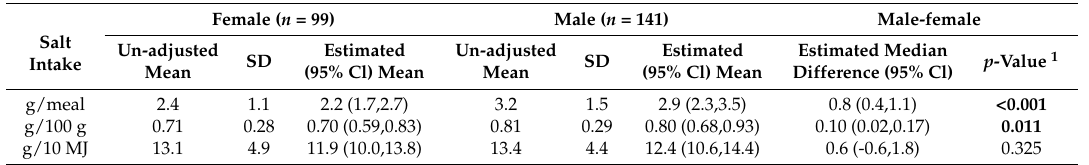
Table 4. Unadjusted and estimated mean salt intake according to gender and effect estimate of intake according to gender (adjusted for age, BMI, and